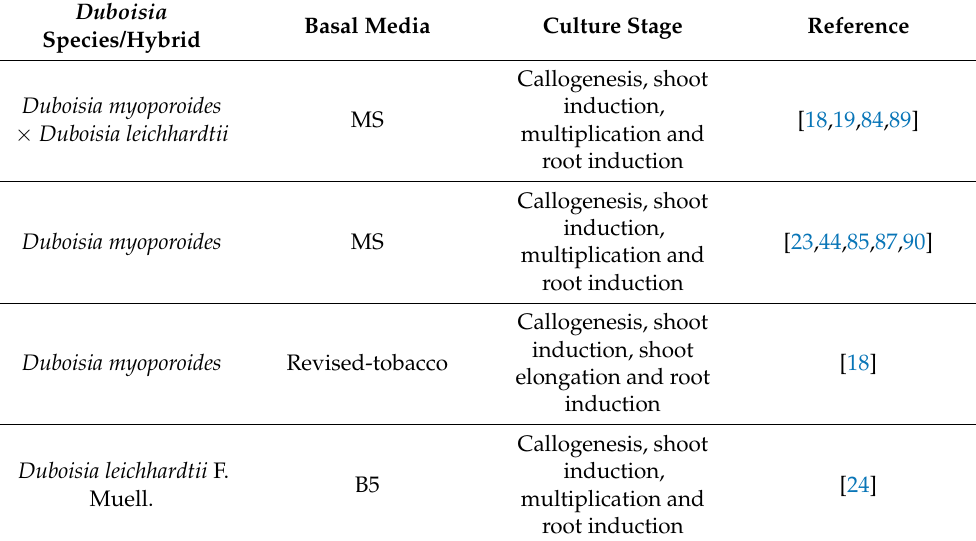
Table 2. Summary of basal media used in Duboisia